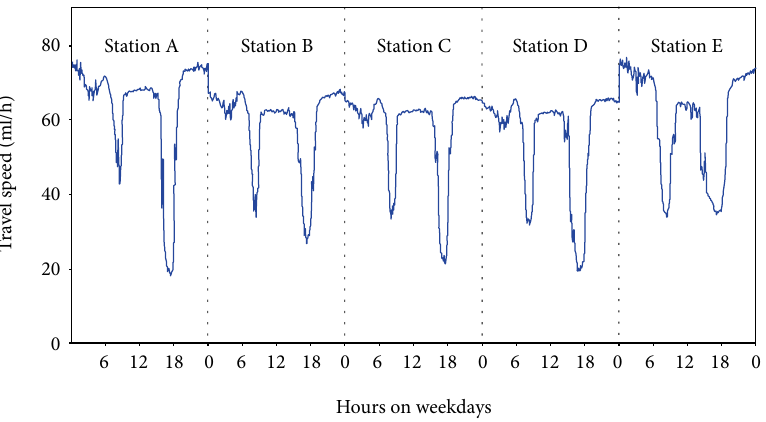
Figure 2: Median value of historical speeds at all stations.